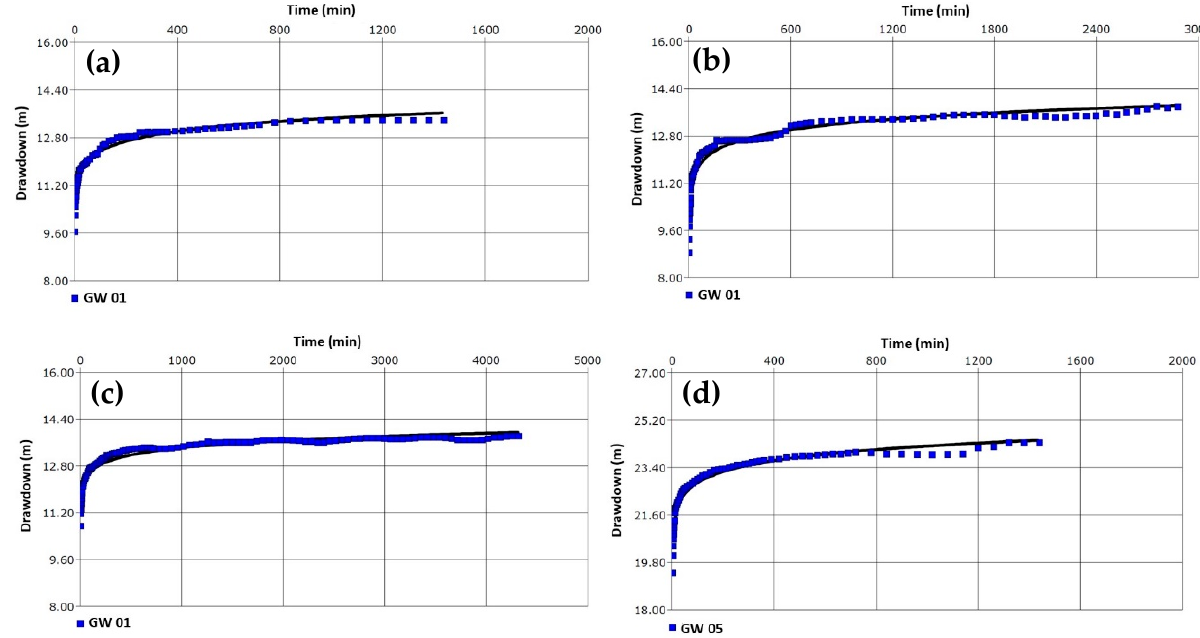
Figure 11. Continuous pumping test curves of unconfined aquifer (aquifer A): GW 01 for 24 h ( a ), 48 h ( b ), and 72 h ( c ), and GW 05 for 24 h ( d ).